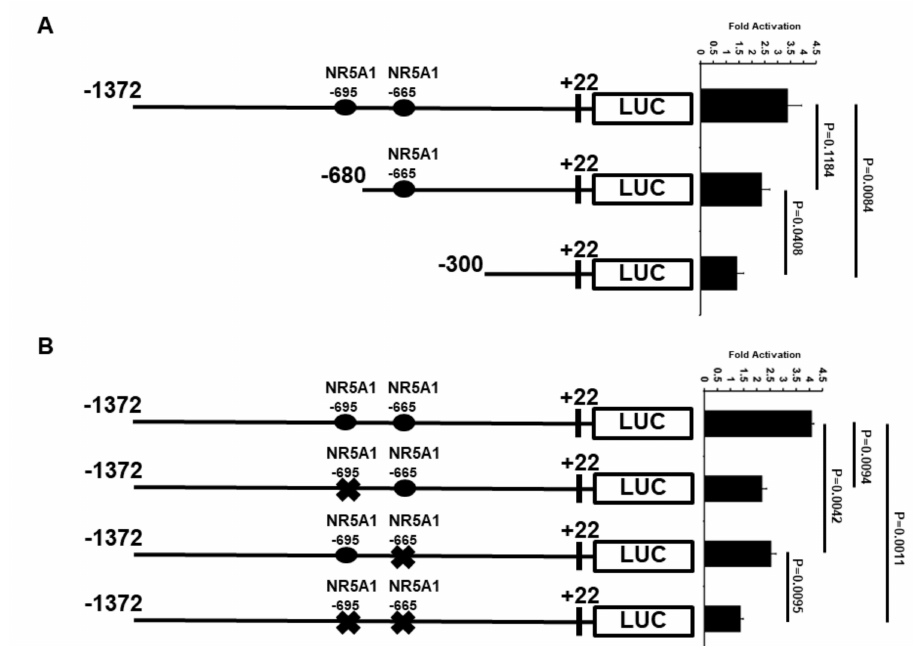
Figure 4. Regions of ATF3 promoter important for transcriptional up-regulation by NR5A1. ( A ) H1299 cells were co-transfected with ATF3 promoter deletion constructs and NR5A1 expression plasmids. Luciferase activities were measured 48 h after transfection and normalized with Renilla activity. Relative LUCactivitywascalculatedandplotted. ( B )H1299cellswereco-transfected NR5A1 expressionplasmids with either − 1372 wild-type, − 695 RE mutated, − 665 RE mutated, or both − 695 and − 665 REs mutated ATF3 promoter constructs. Luciferase activities were measured 48 h after transfection and normalized with Renilla activity. Relative LUC activity was calculated and